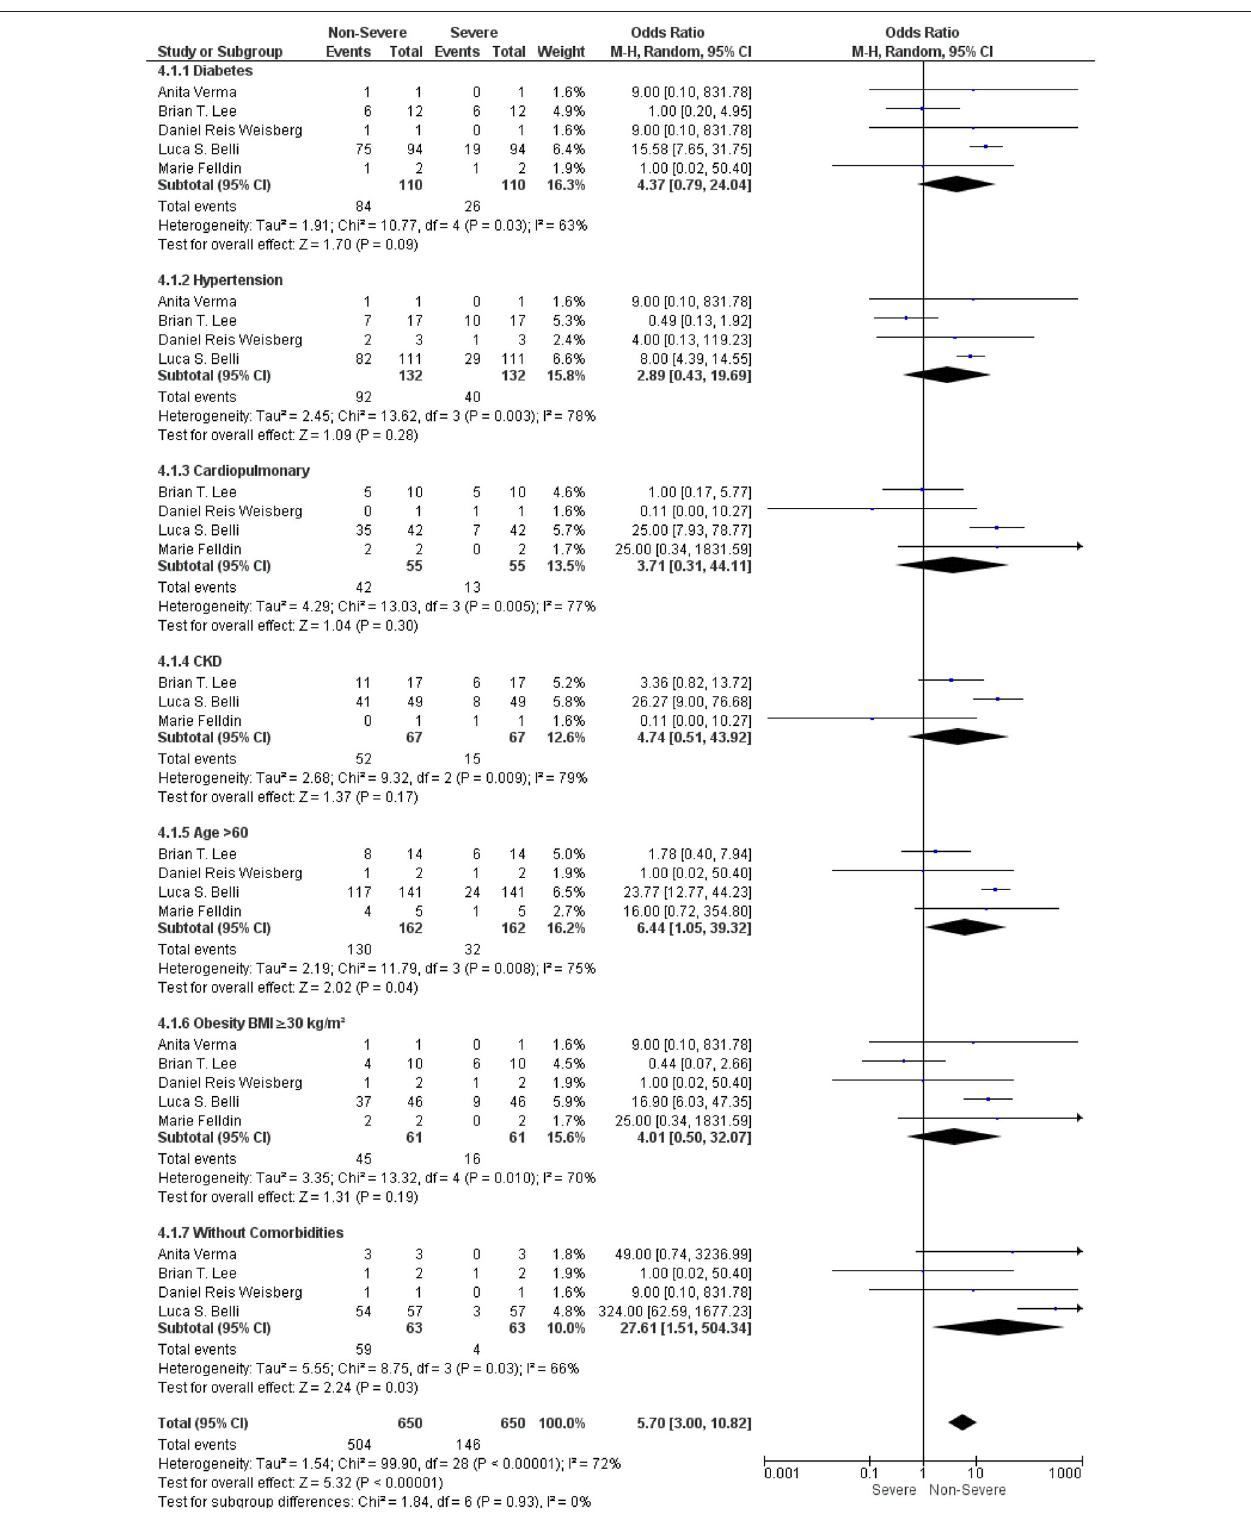
Frontiers in Medicine |